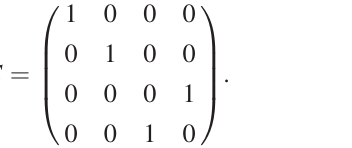
FIG. 7. We may move a logical qubit defined by operators along a given sublattice. We first multiply the logical ˆ O by . After measuring i γη in the next code cycle, we extend the r ˆ X → ˆ X ⊗ i γη logical surface code cycle and restore